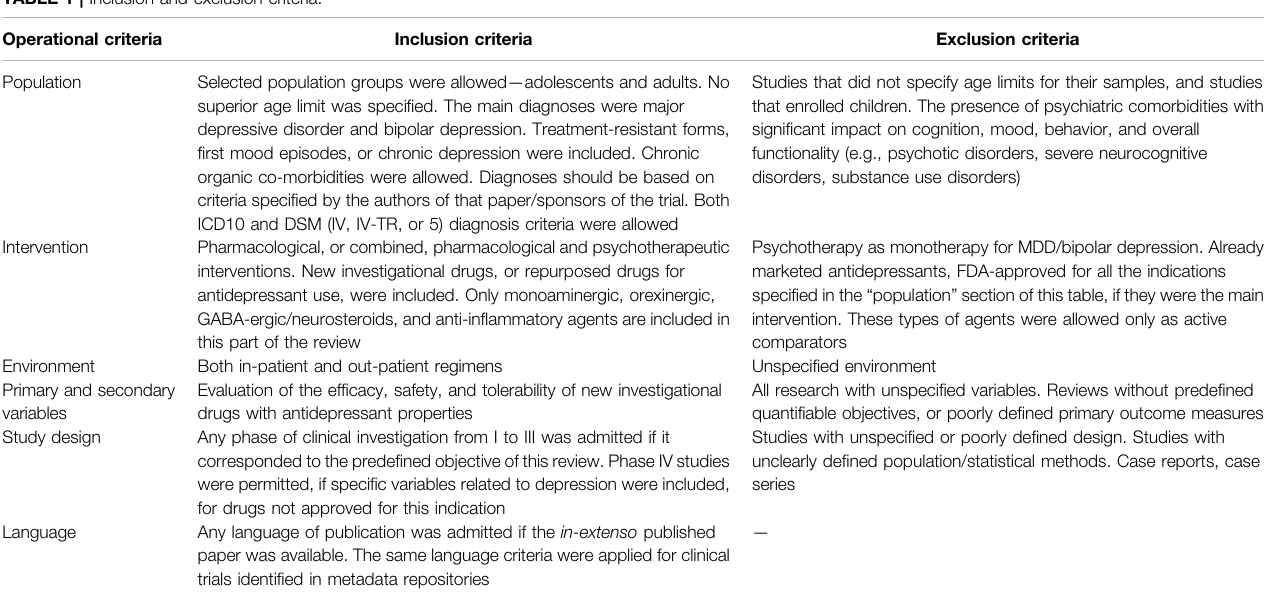
TABLE 1 | Inclusion and exclusion